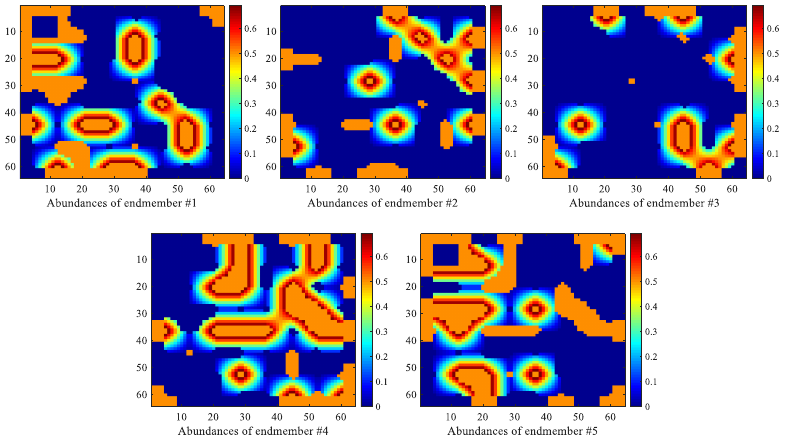
Figure 5. True abundance maps of nice endmembers in data